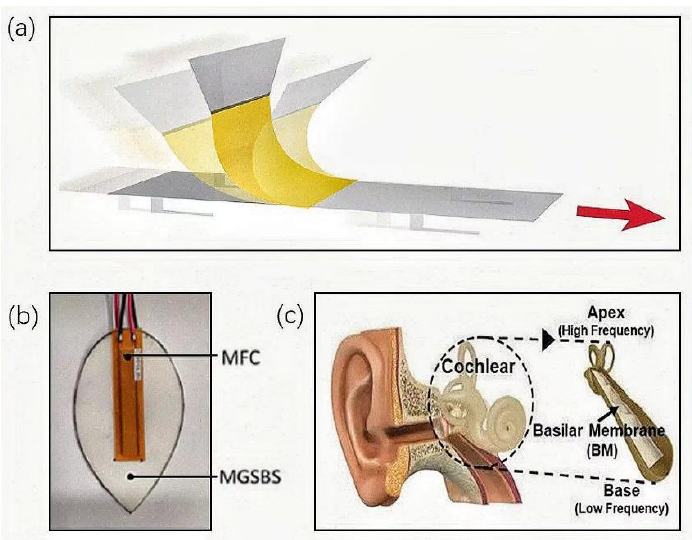
Figure 5. ( a ) Thin piezoelectric mobile robot with a curved tail [54]. ( b ) Piezoelectric-driven self- healing leaf prototype [55]. ( c ) Acoustic sensor [56]. healing leaf prototype [55]. ( c ) Acoustic sensor